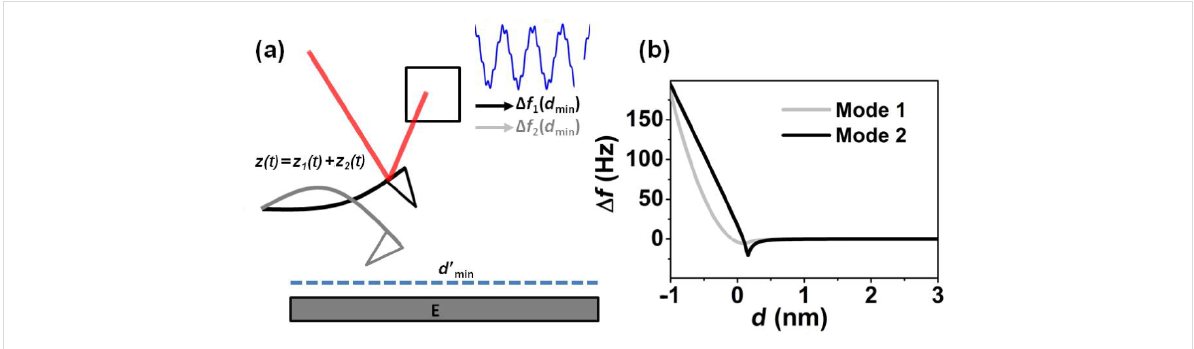
Figure 1: (a) Scheme of the first two eigenmodes of a cantilever and the tip deflection under bimodal excitation. In bimodal FM-AFM changes in the interaction force produce changes in the resonant frequency. The feedback loop keeps the resonant frequency of the 1 st mode constant by changing the minimum tip–surface distance. (b) Frequency shifts of the 1 st and 2 nd modes as a function of the tip–surface